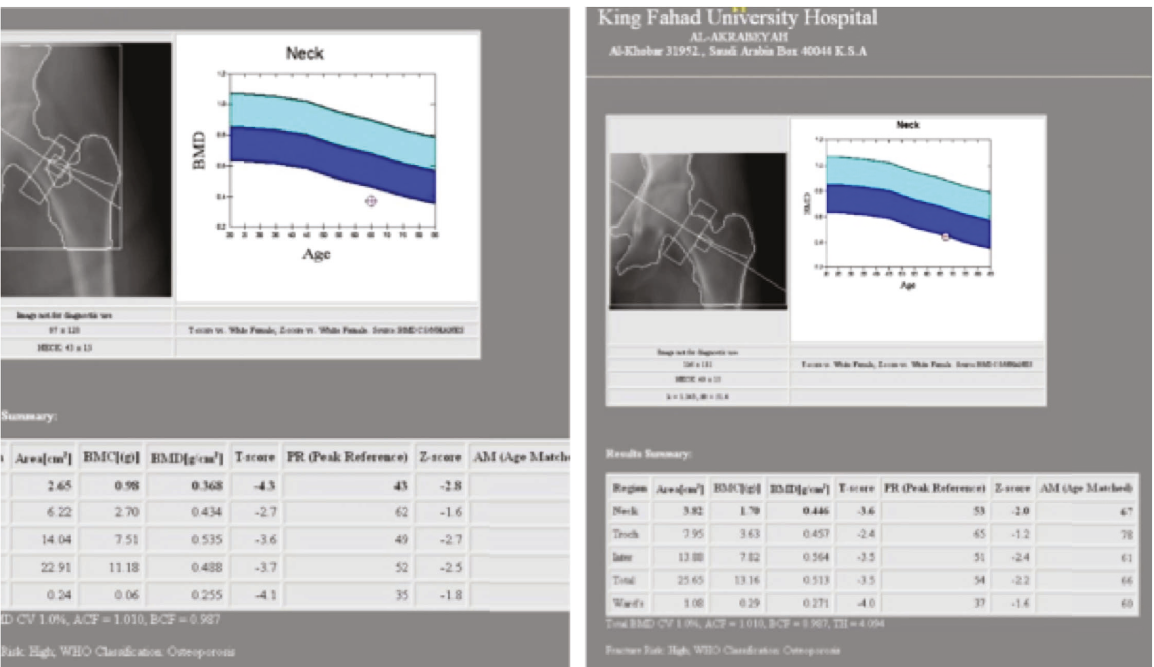
Figure 3: Pretreatment and post-treatment DXA scans of the hip.